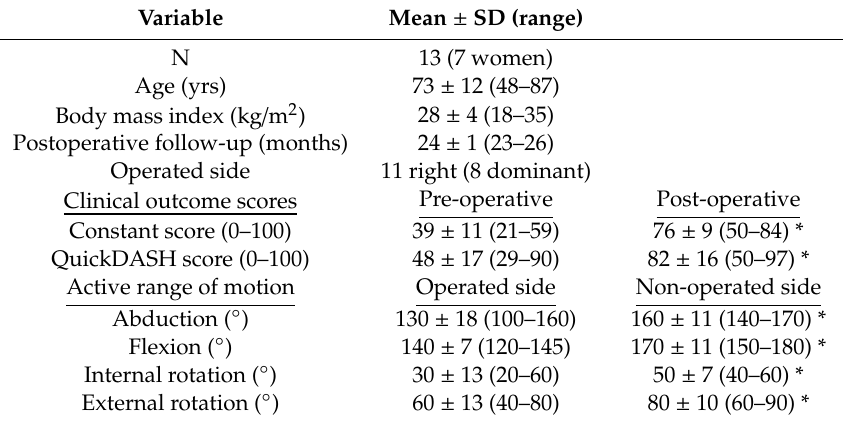
Table 1. Patient